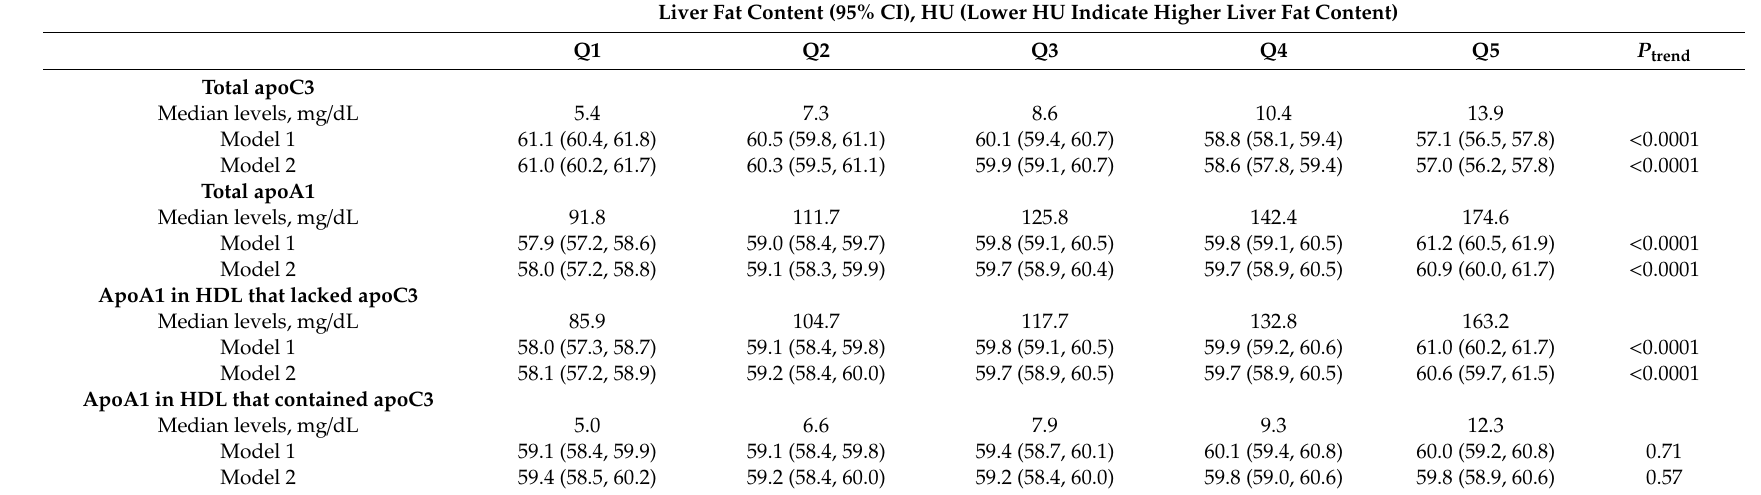
Table 2. Least-square means of baseline liver fat content by apolipoprotein quintile in